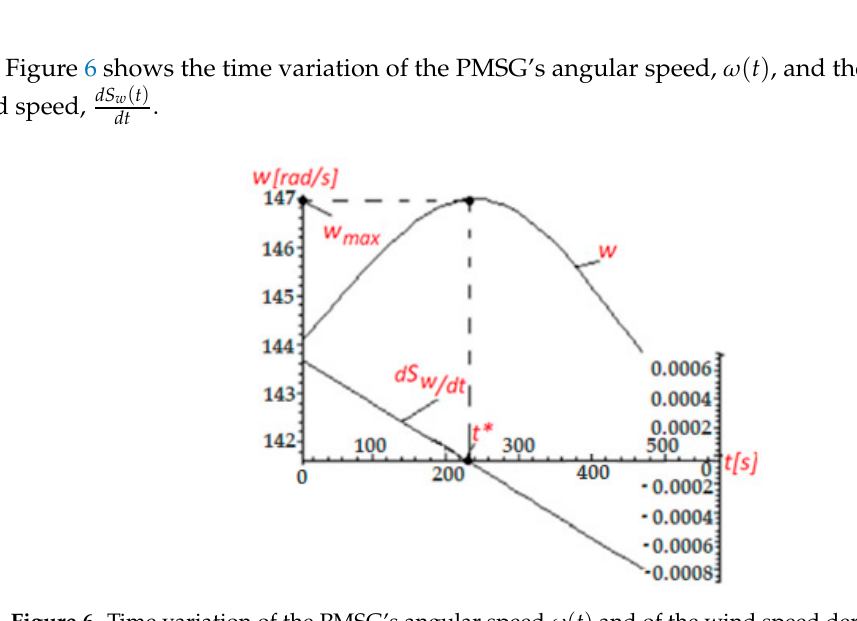
Figure 6. Time variation of the PMSG’s angular speed 𝜔(𝑡) and of the wind speed derivative (cid:3031)(cid:3020) (cid:3298)